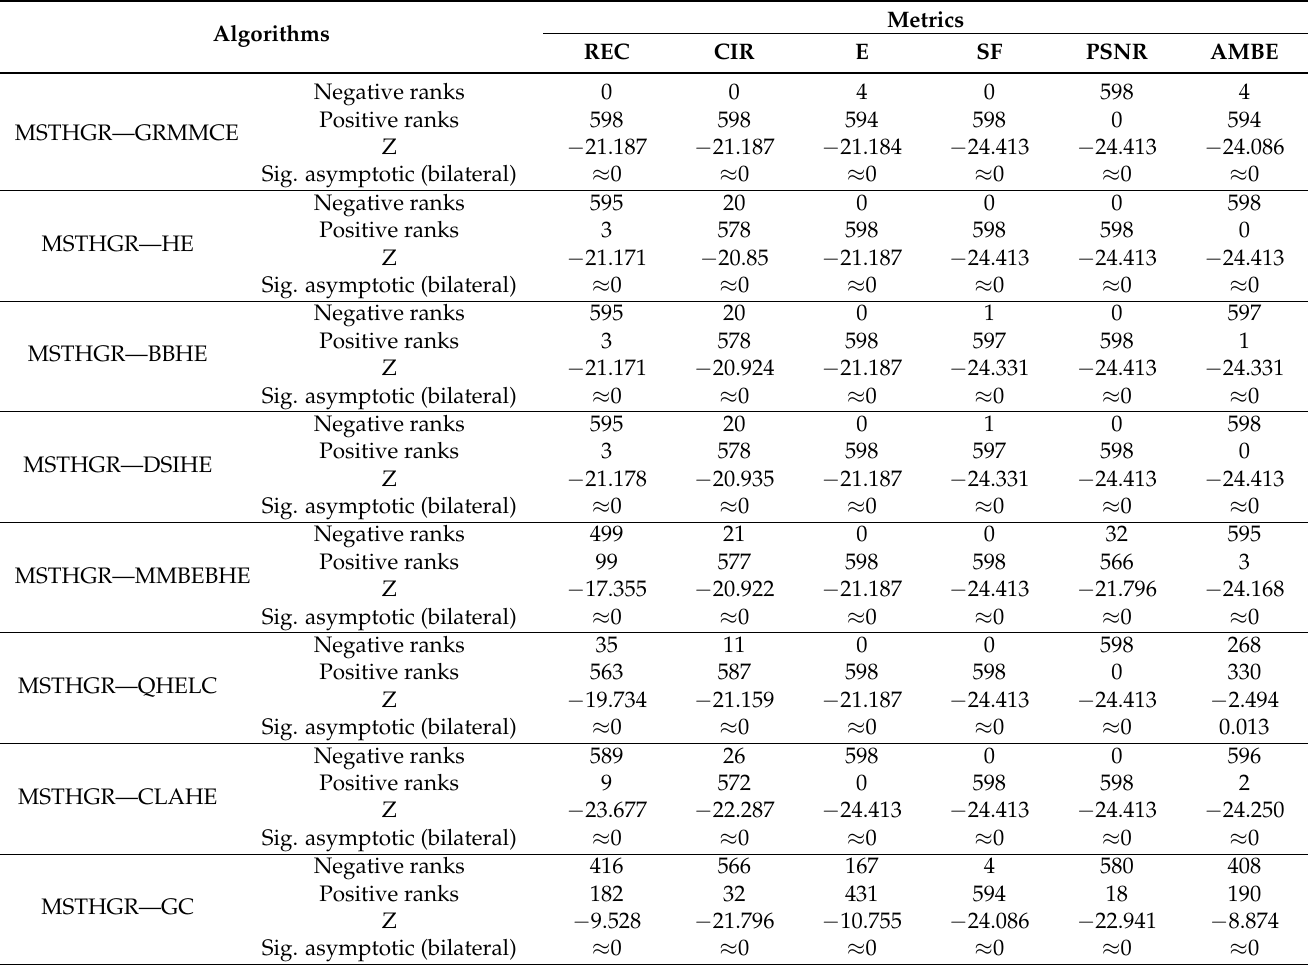
Table 2. The Wilcoxon Signed Rank Test for paired